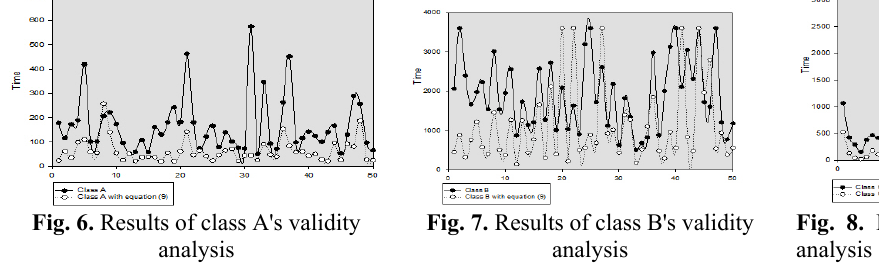
Fig. 6. Results of class A's validity analysis